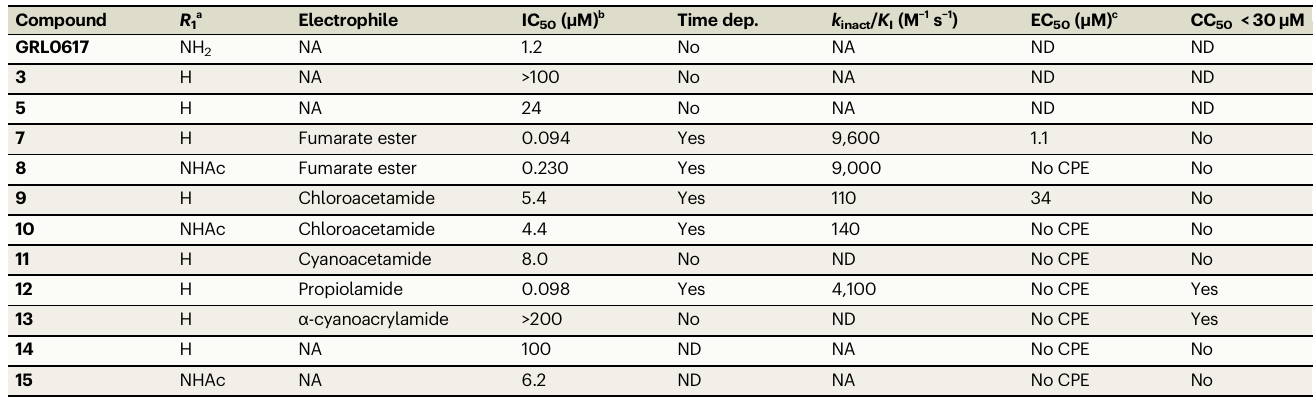
Table 1 | PLpro inhibition and SARS-CoV-2 antiviral activity